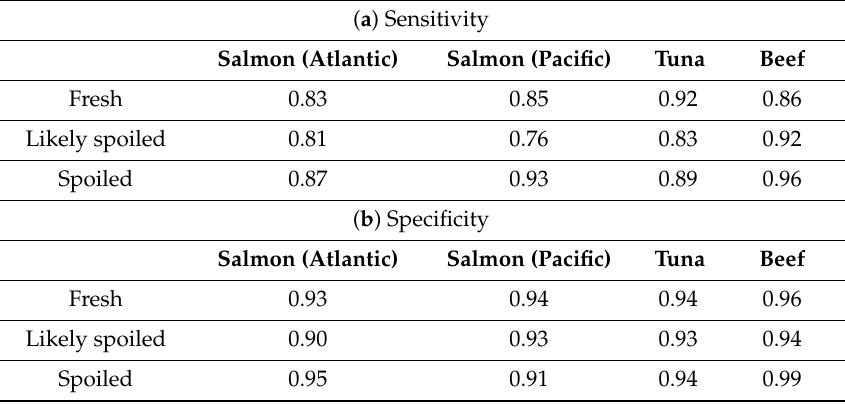
Figure 6. Confusion matrix ( a ) for a conventional two-by-two (2 × 2) matrix ( b ) of Salmon (Atlantic) “fresh”: TP is the True Positive of “fresh”, FP is the False Positive of “fresh”, FN is the False Negative of “fresh”, and TN is the True Negative of “fresh”. Table 4. Calculation of sensitivity and specificity for four machine learning models. ( a ) Sensitivities show how well the models give correct answers for each class; ( b ) Specificities show how well the models reject the spectral response data from other classes. Both sensitivity and specificity are high enough to demonstrate the performance of machine learning models.